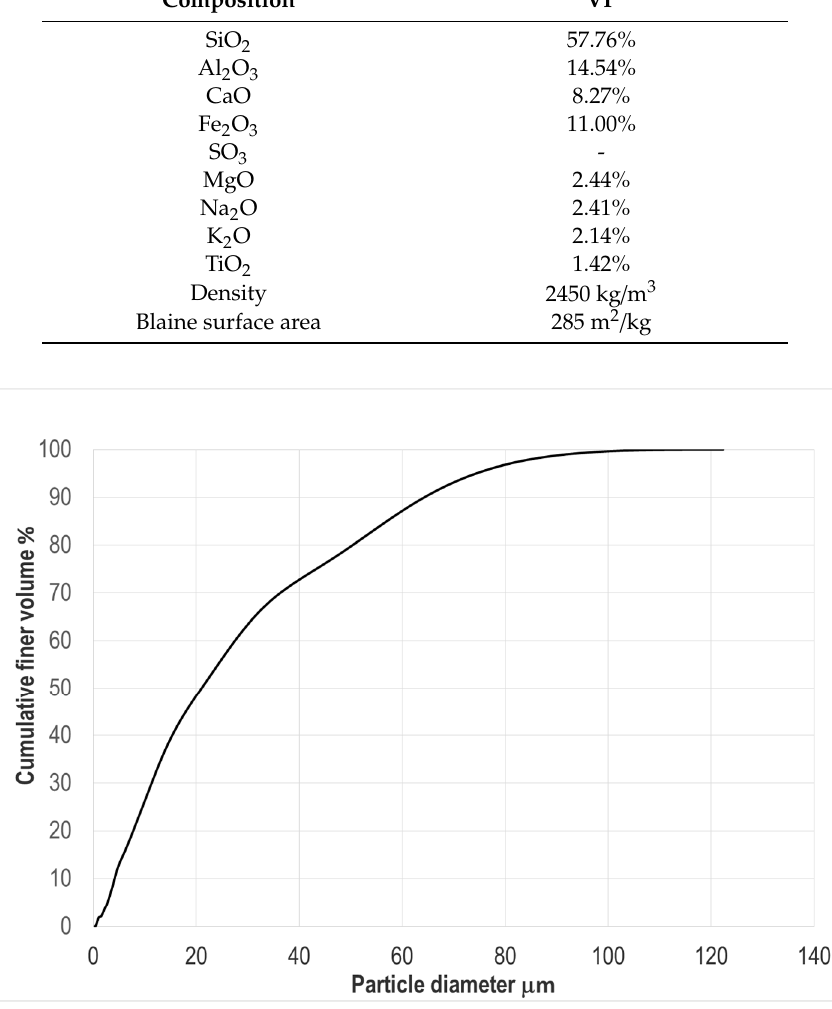
Table 1. Physical and chemical properties of VP.